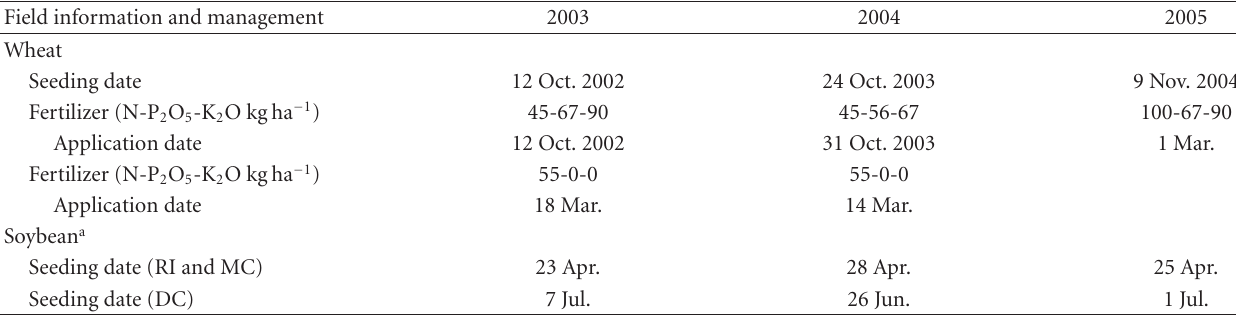
Table 1: Fertilizer rates, application dates, and seeding dates for wheat and soybean cropping systems from 2003 to 2005. Field information and